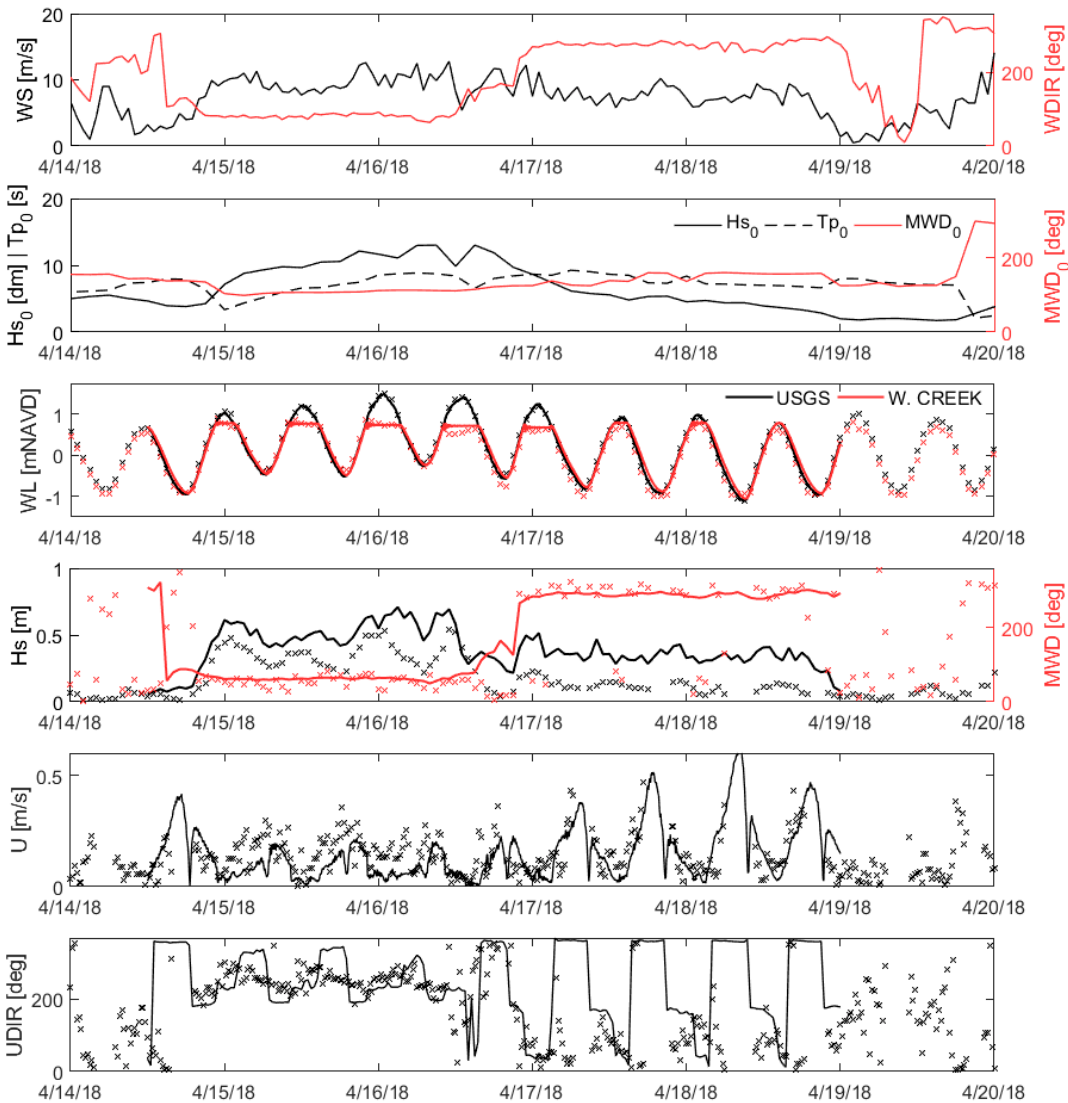
Figure 7. Collected data (X markers) for one week of the Spring 2018 deployment and modeled results (solid lines) for calibration period. TOP: Wind speed and direction as observed at Sandy Hook. SECOND: Significant wave height, period, and direction at offshore wave boundary extracted from Wavewatch III (WW3) hindcast. THIRD: Water levels at the USGS station and Waackaack Creek pressure gage. FOURTH: Significant wave height and direction at the offshore acoustic Doppler current profiler (ADCP). BOTTOM: Current speed and Direction at the Ebb Shoal Nortek ADCP.